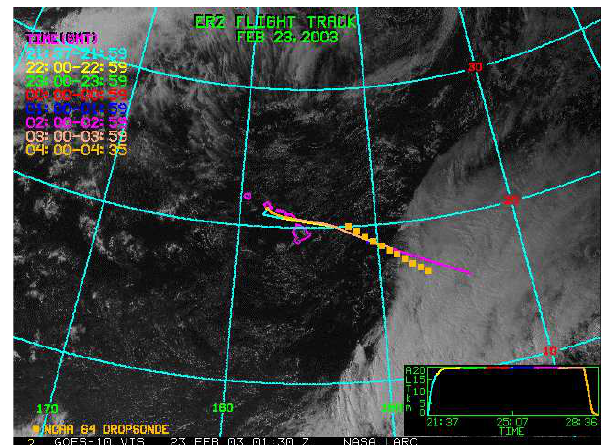
Fig. 1. GOES-10 visible channel image, 23 February 2003. ER- 2 route and the drop-sondes positions are shown (from http://